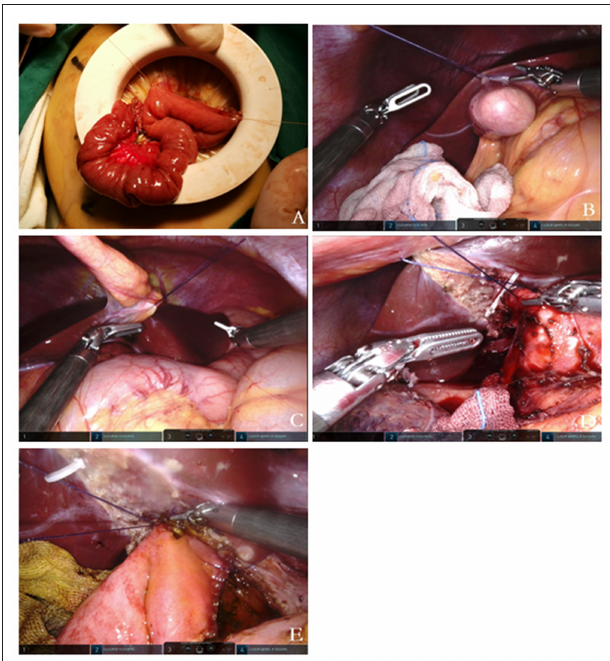
FIGURE 2 | (A) Extracorporeal Roux-en-y jejunojejunostomy; the baseplate of the device can serve as a container. (B–E) Sequential traction suture; (B) stitch and lift the gallbladder fundus; (C) stitch and lift the round ligament; (D) stitch and lift the common bile duct before dissecting the choledochal cyst; (E) stitch and lift the common hepatic before the